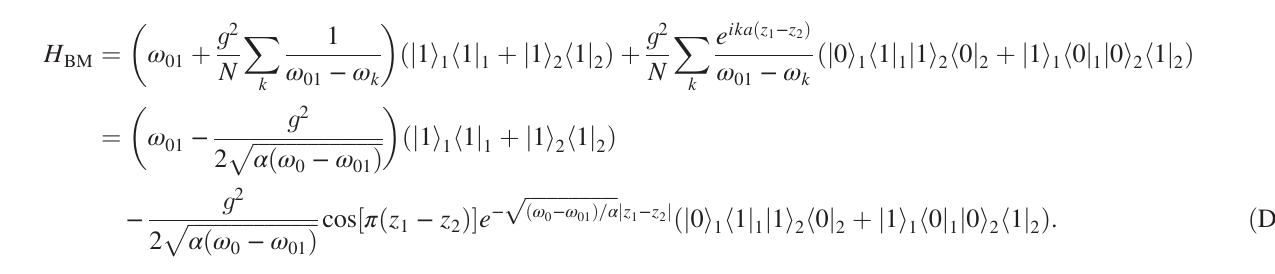
ffiffiffiffiffiffiffiffiffiffiffiffiffiffiffiffiffiffiffiffiffiffiffiffi p α ð ω − ω 0 01 Þ